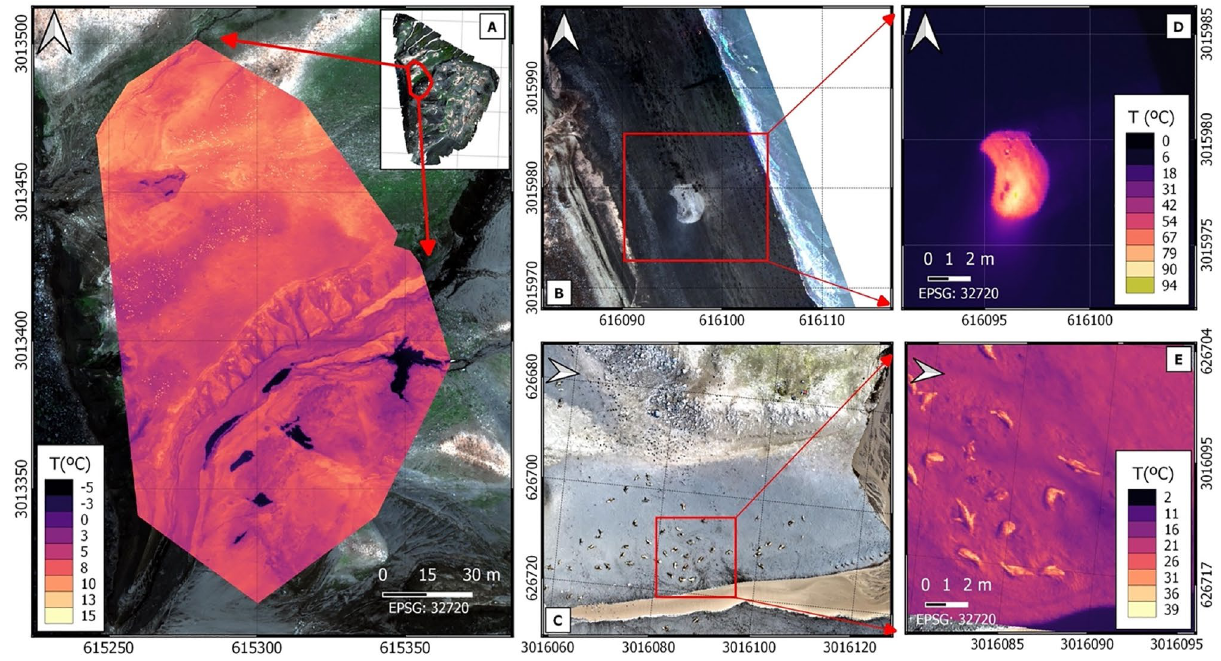
Figure 3. Thermal imagery. Panel ( A ): thermal mosaic of a section of Vapour Col (8.5 cm/pixel). Penguins are distinguished throughout the colony as small dots around 15 °C; Panel ( B ) and ( D ): RGB (Red-668, Green-560 and Blue-475 bands) and thermal picture of fumarole at Fumarole Bay (5.4 cm/pixel), respectively; Panel ( C ) and ( E ): RGB and Thermal image of Fur seals at Baily Head (5.4 cm/pixel),